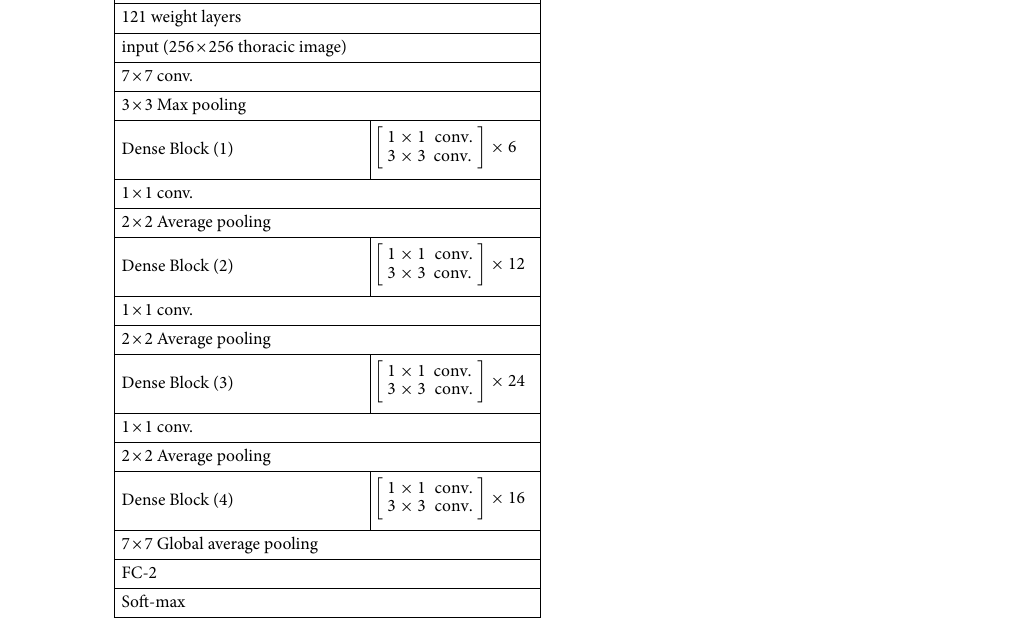
Table 4. ConvNet configuration of DenseNet.